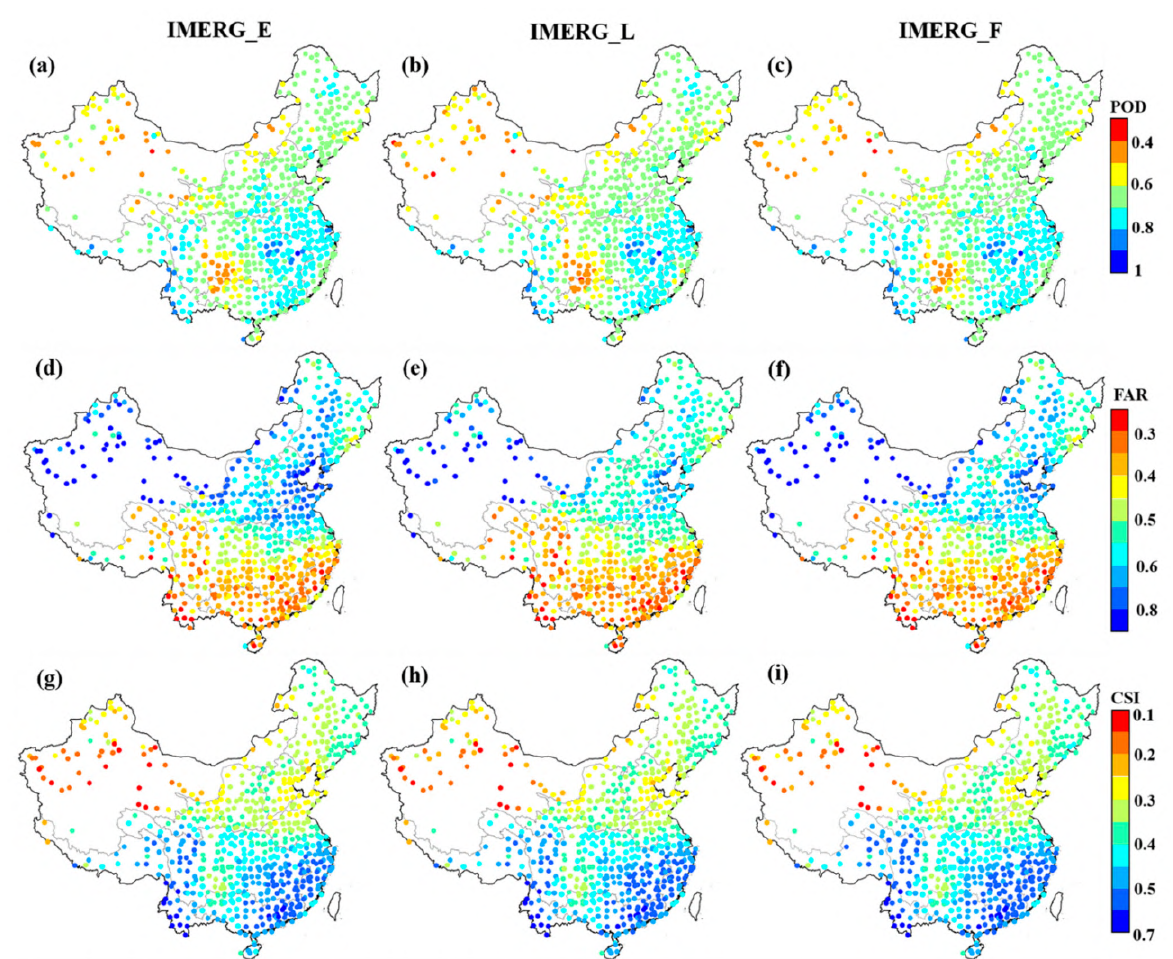
Figure 3. Spatial distribution of categorical metrics (POD ( a – c ); FAR ( d – f ); and CSI ( g – i )) for IMERG_E (Column 1), IMERG_L (Column 2) and IMERG_F (Column 3) at daily level from 2008 to 2017. Table 1. Performance metrics associated with IMERG products in each basin from 2008 to